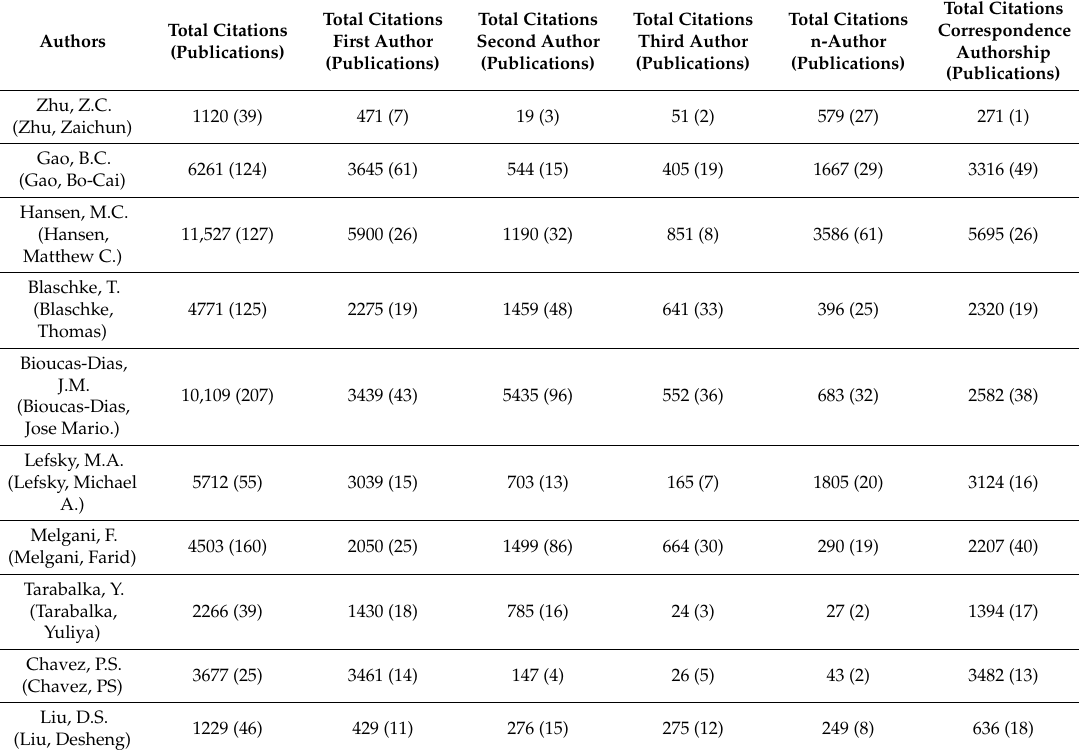
Table 6. A nuanced version of total citations of 10 authors, randomly